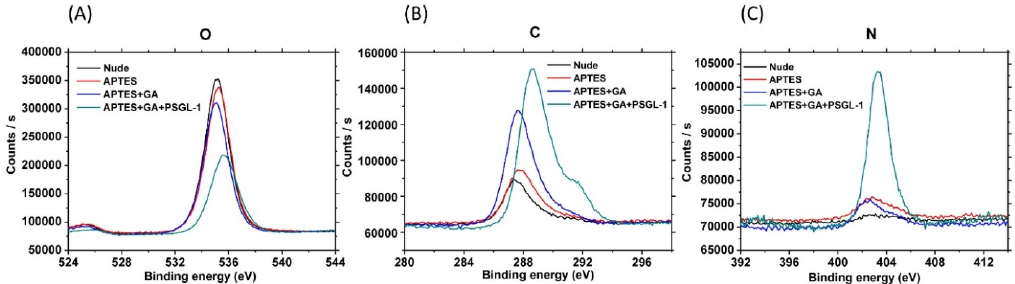
Figure 2. XPS analysis upon PSGL-1 immobilization on the poly-Si surface ( A ) Oxygen XPS spectra; ( B ) Carbon XPS spectra; and ( C ) Nitrogen XPS spectra at each immobilization step.